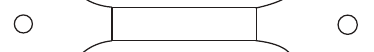
Figure 1: Typical creep aging sample.